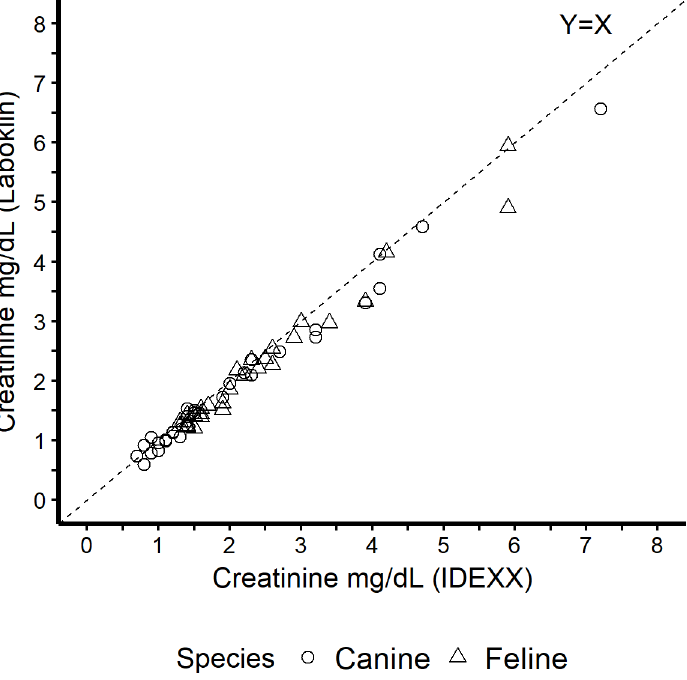
Fig 3. Comparison of creatinine (sCr) measures between laboratories. Dashed line is the line of equality.